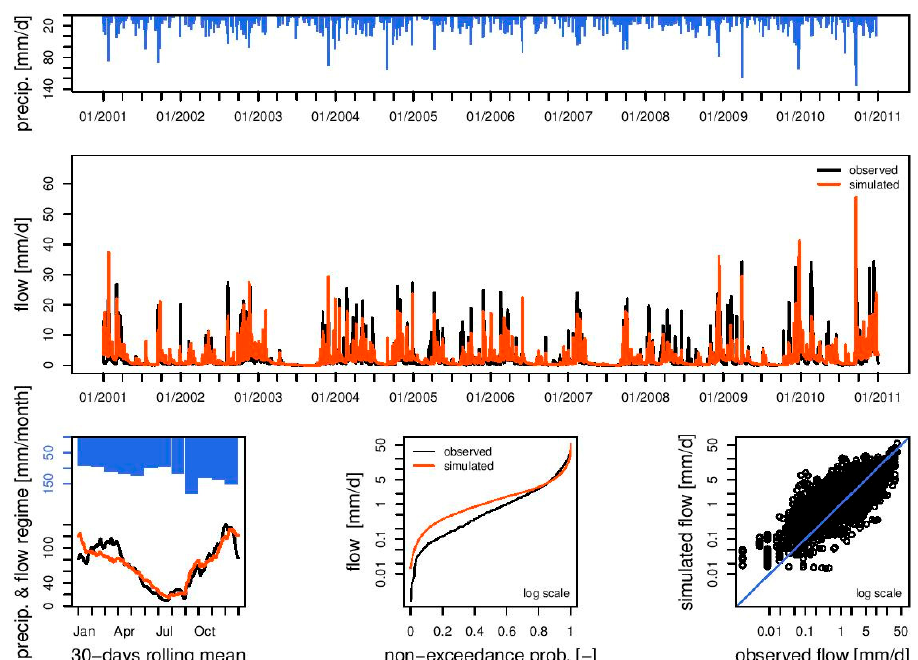
Figure 4. Hydrological modelling results using the GR6J model for the Mali Otok station on the Nanošˇcica River for the calibration period (2001–2010; 2000 is used for model warm-up).